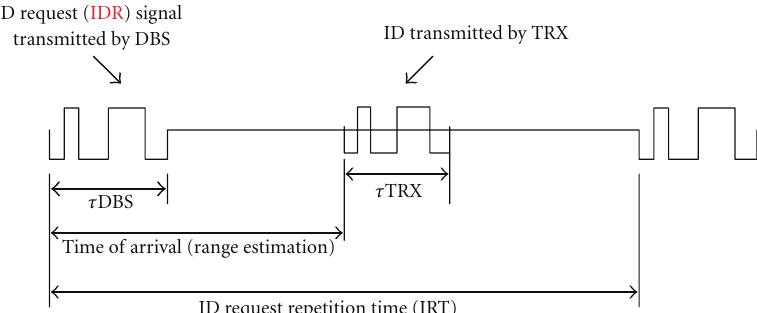
Figure 2: DBS ID signal and TRX response signal in an IRT period.